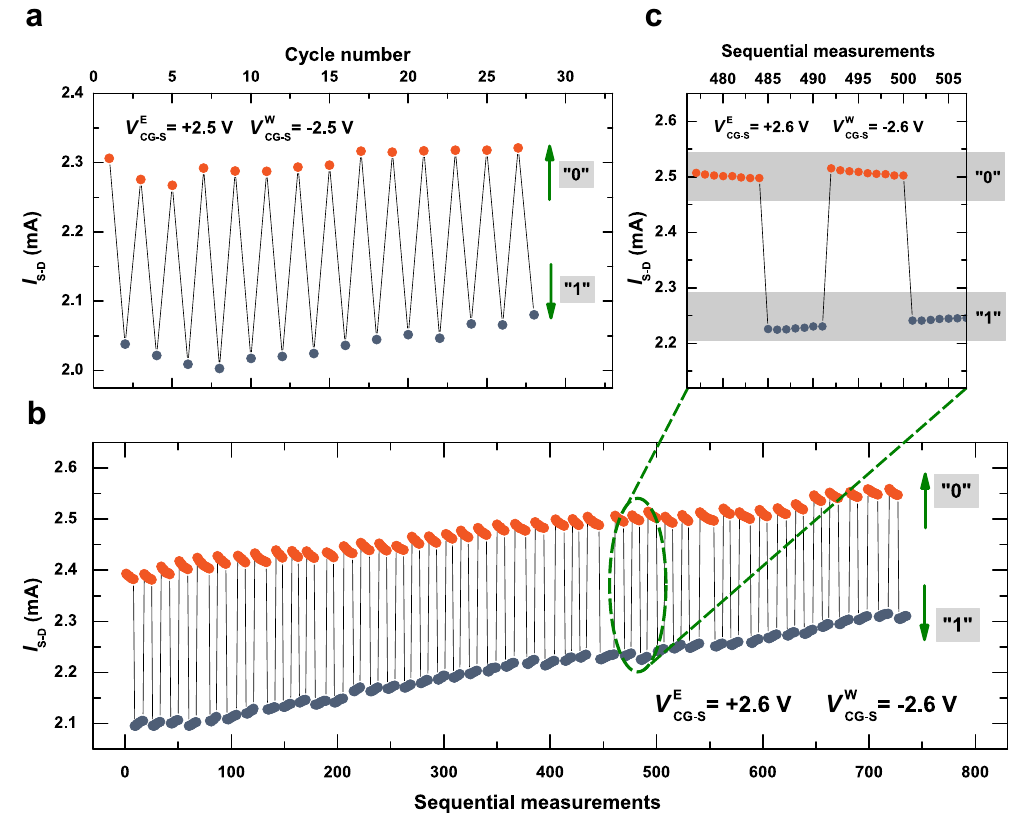
Figure 3. Erase-read-write-read cycles. “0” and “1” states are prepared by application of erase and write SE and SW , respectively, and read via the source-drain current, I voltages, − V − V CG S-D , with 1.0 V bias across the CG channel and zero bias on the control gate. ( a ) Single read measurements subsequent to each erase or write. ( b ) Part of an extended measurement with multiple reads (every 1 s) following each erase or write operation ( > 80 cycles shown). ( c ) A detail of a portion of the data in b showing a slight convergence of I S-D for “0” and “1” states following erase and write. In ( b , c ) the number of reads following each write or erase is